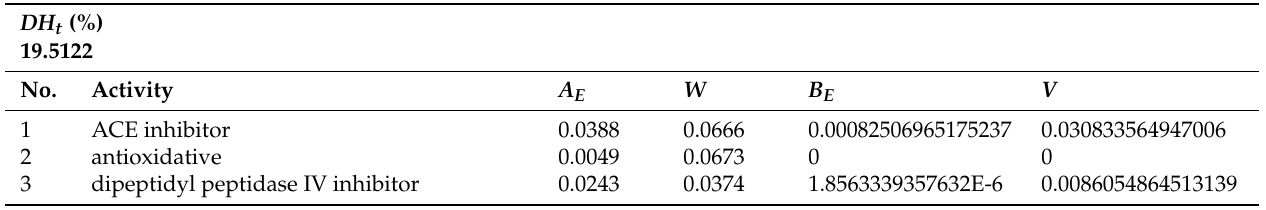
Table A34. A E , DH t , W , B E and V values from RubisCO of Halophila stipulacea . In silico enzymatic cleavage was carried out by using metridin.